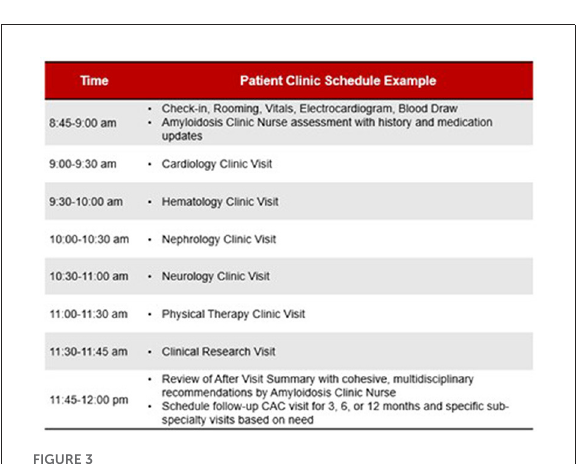
FIGURE3 Workflow for the Ohio State University Comprehensive Amyloidosis